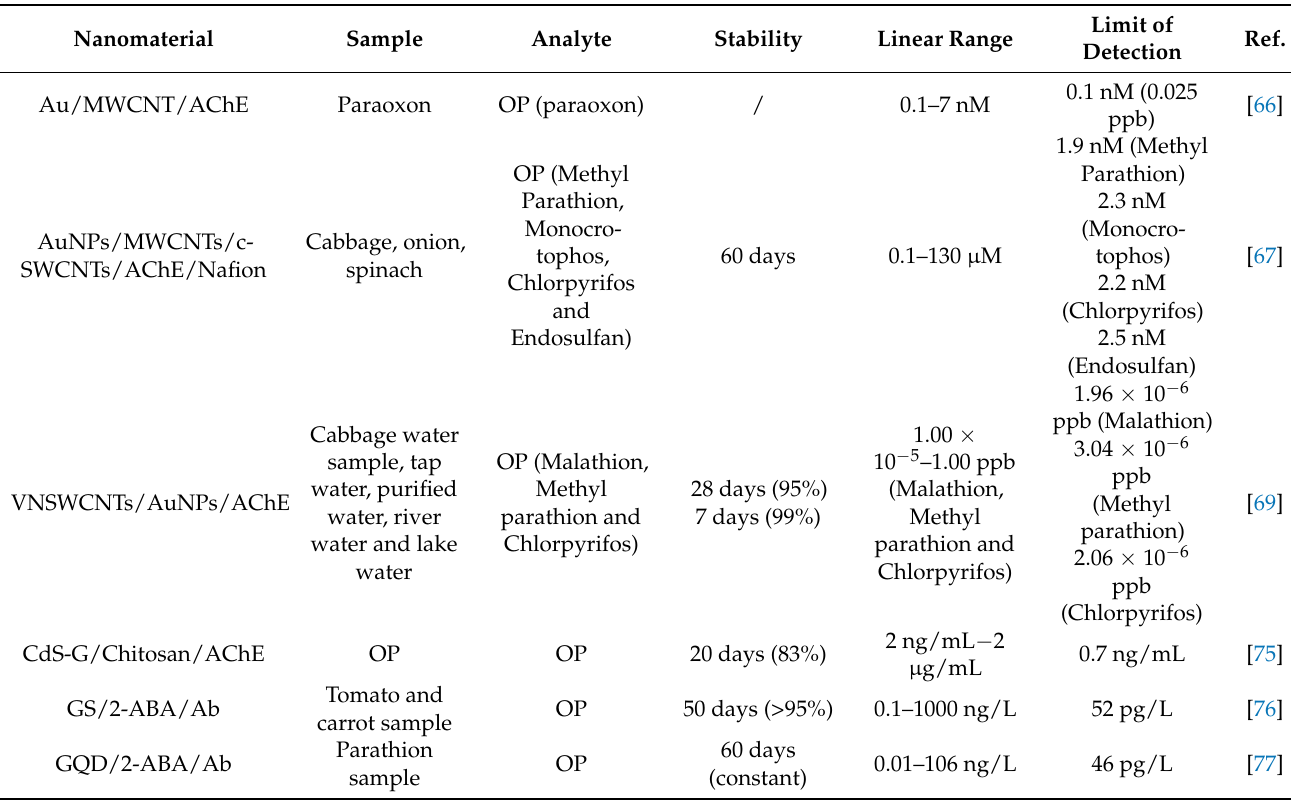
Table 4. Representative studies of electrochemical biosensor for detecting pesticides from food sample by carbon-based